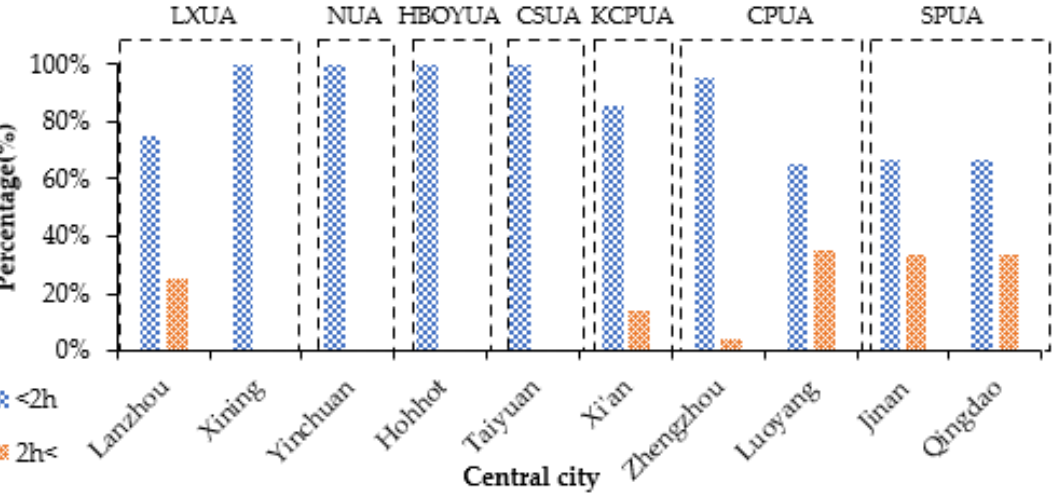
Figure 4. The proportion of 2 h traffic circle coverage in central cities. Comparing the 2 h HSR travel coverage of central cities in each urban agglomeration (Figure 5), when the central city was closer to the geometric center of the urban agglomeration, the HSR travel time for the central city to reach other points in the urban agglomeration was generally lower, and it was easier to expand the scope of its travel traffic circle. Central cities of SCUA and CPUA, Taiyuan and Xi’an, were located in the center of the urban agglomeration, and their location largely affected the size of their 2 h HSR travel traffic circle, with the two central cities covering a higher proportion of the 2 h HSR travel of the coverage ratio of the 2 h HSR travel circle between the central cities of LXUA, with Lanzhou covering 75% and Xining covering 100%, a 1.3-fold difference. The proportion